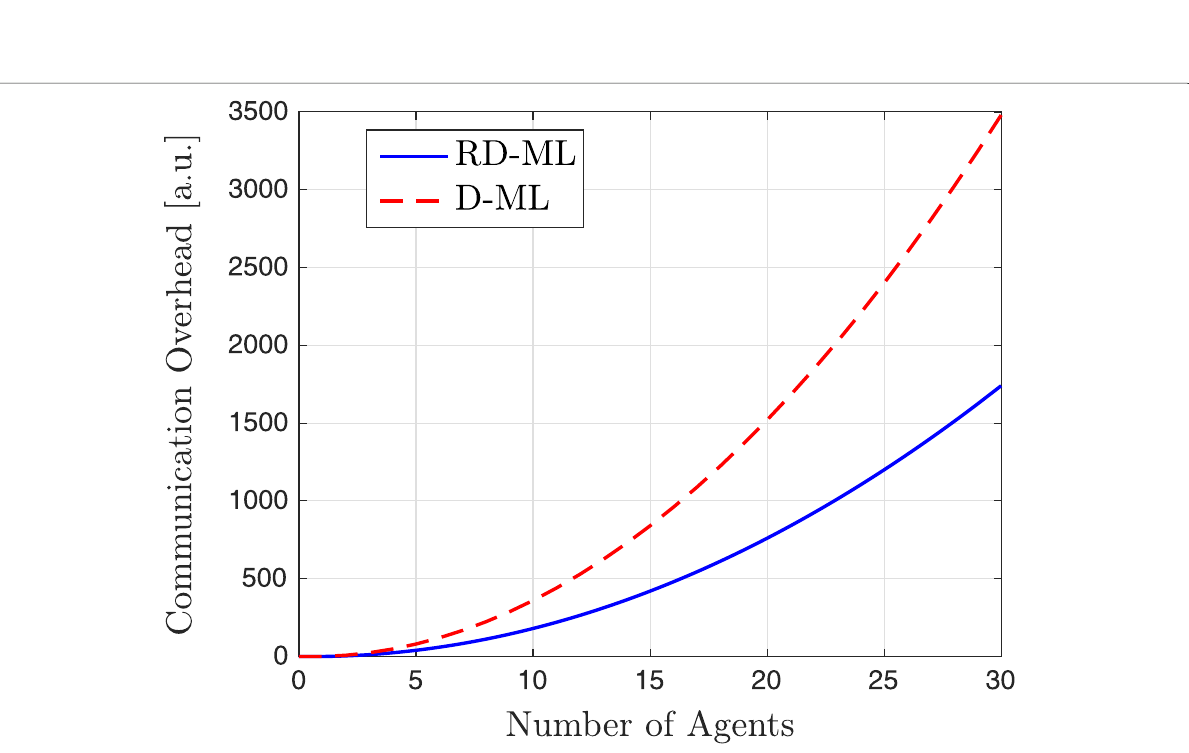
Fig. 12 Communication costs for a fully-connected